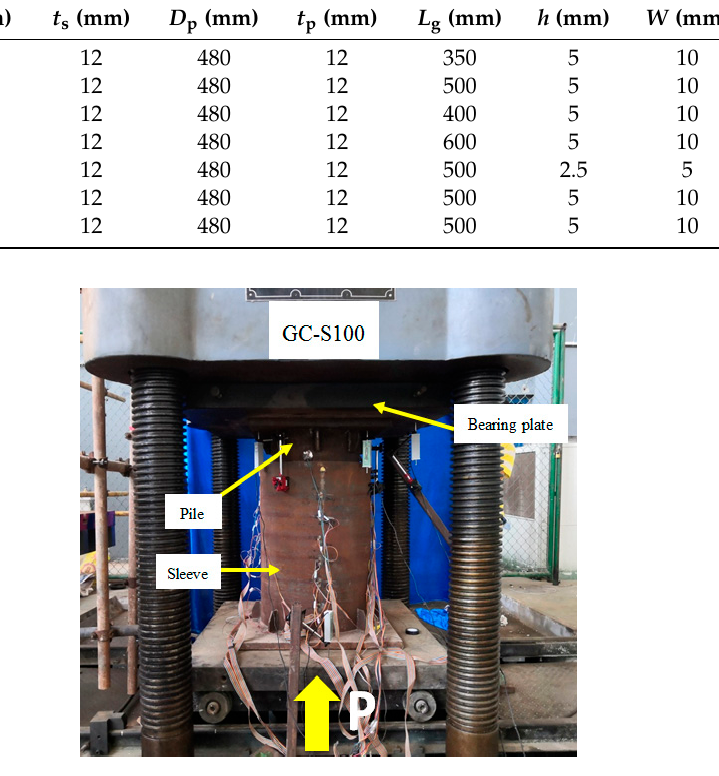
Figure 8. Schematic diagram of specimen loading in grouted connection. Appl. Sci. 2020 , 10 , x FOR PEER REVIEW